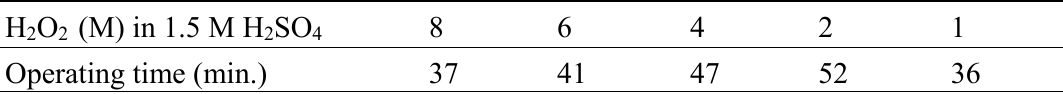
Table 2. Oxidant concentration optimization data for five-cell DBFC stack with 8 wt. % NaBH and 11 wt. % NaOH. 4